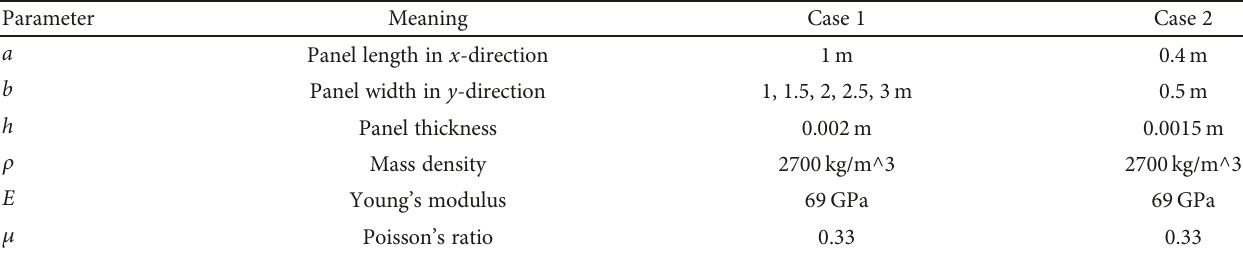
Table 1: Physical parameters of the